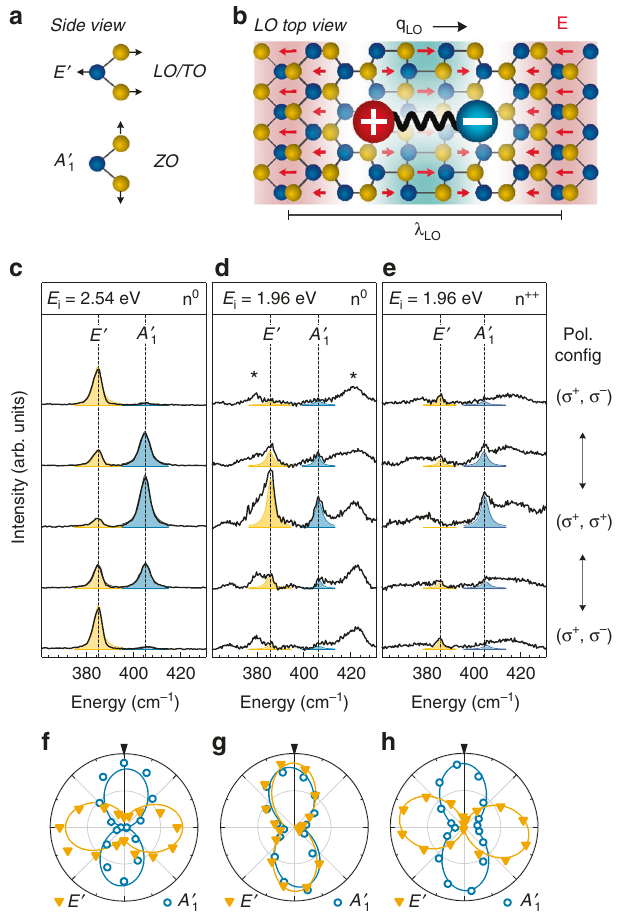
Fig. 2 Polarization of phonon modes in dependence of the charge carrier density. a Raman active optical phonons in MoS 2 : the in-plane, polar E ’ mode and the out-of-plane, homopolar A ’ 1 mode. b Illustration of the movement of the atoms for the LO phonon mode. The resulting electric fi eld is indicated with red arrows. The interaction strength between the macroscopic electric fi eld and an exciton depends on the ratio between the exciton radius and the phonon wave vector. c – e Polarization resolved Raman spectra for circularly polarized light from a 1L-MoS 2 fl ake in a fi eld effect device with polymer electrolyte gate at T = 300 K. The fi lled curves are Lorentzian fi ts to the data. c Non-resonant excitation and low charge carrier density n 0 ( V TG = − 0.5 V, V BG = − 40 V). d Resonant excitation and low charge carrier density n 0 . e Resonant excitation and high charge carrier density n ++ ( V TG = 0 V, V BG = 0 V). Asterisks mark additional Raman signatures that are visible under resonant excitation and that are subject to discussion in literature. f – h Polar-plots of the normalized amplitude of the fi tted peaks shown in the panel above the respective plot versus the rotation of the quarter wave plate. The black arrows mark 0°; 0° and 90° correspond to the ( σ + , σ + ) and ( σ + , σ − ) con fi gurations,